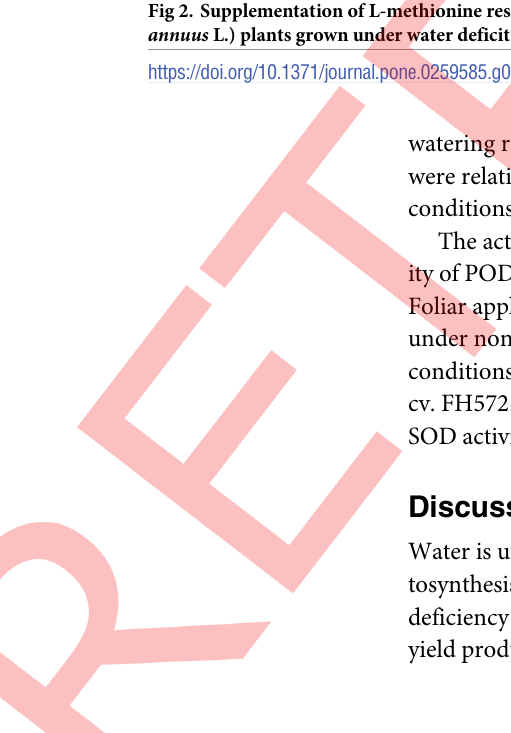
Fig 2. Supplementation of L-methionine restored (A) chlorophyll a, (B) chlorophyll b, and (C) chlorophyll a/b ratio in sunflower ( Helianthus annuus L.) plants grown under water deficit condition (Mean ±